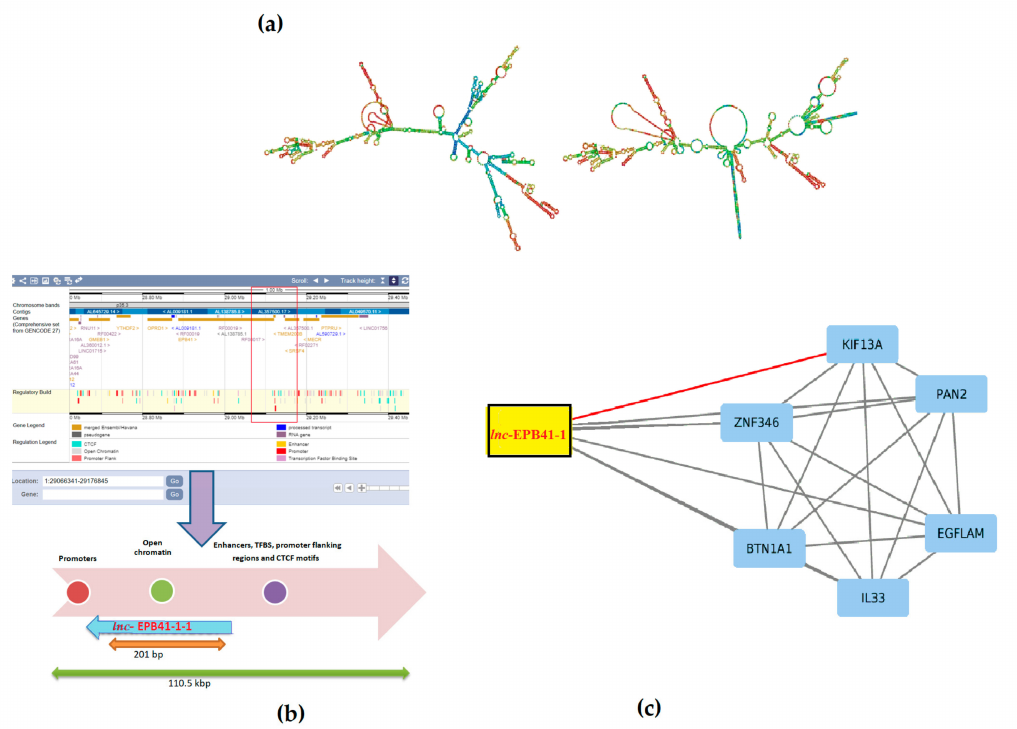
Figure 1. ( a ) RNAfold prediction showing base-pairing probabilities of the secondary structures of lncRNA wherein the centroid secondary structure (right)is shown to have a minimum free energy(MFE) of − 322.60 kcal/mol indicating that the structure is in thermodynamic ensemble; ( b ) plausible role of lncRNA towards regulation with lnc -EPB41-1-1 known to be associated with open chromatin elements (OCE), promoters and enhancers; ( c ) lnc -EPB41-1-1 potentially shown to be interacting with KIF13A with the red edge indicating the predictions from lncPro and RNA Protein Interaction predictor